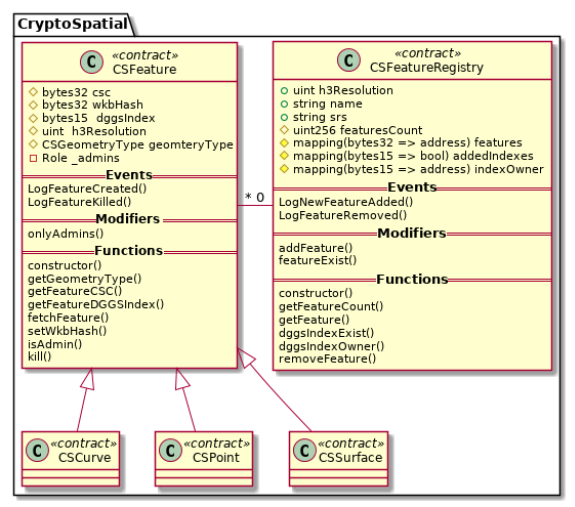
Figure 2. Crypto-Spatial Library Class